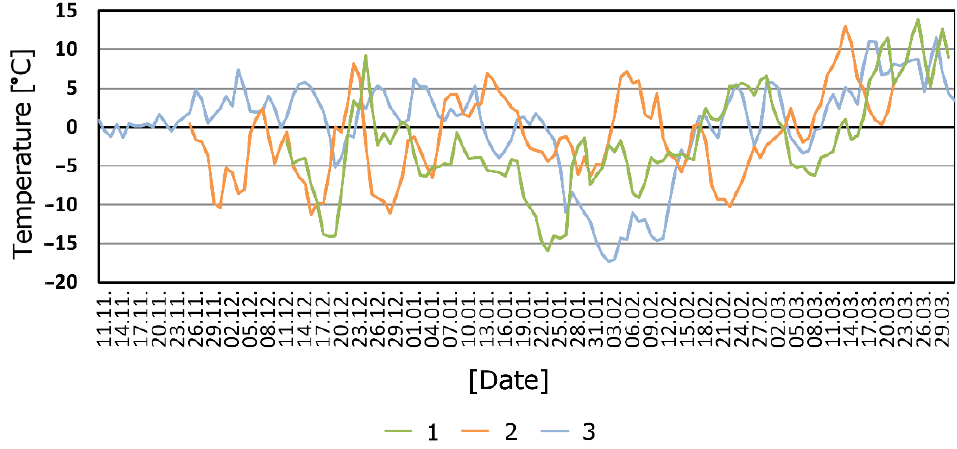
Figure 2. Average air temperature values in the ice phenomena period for the winter seasons